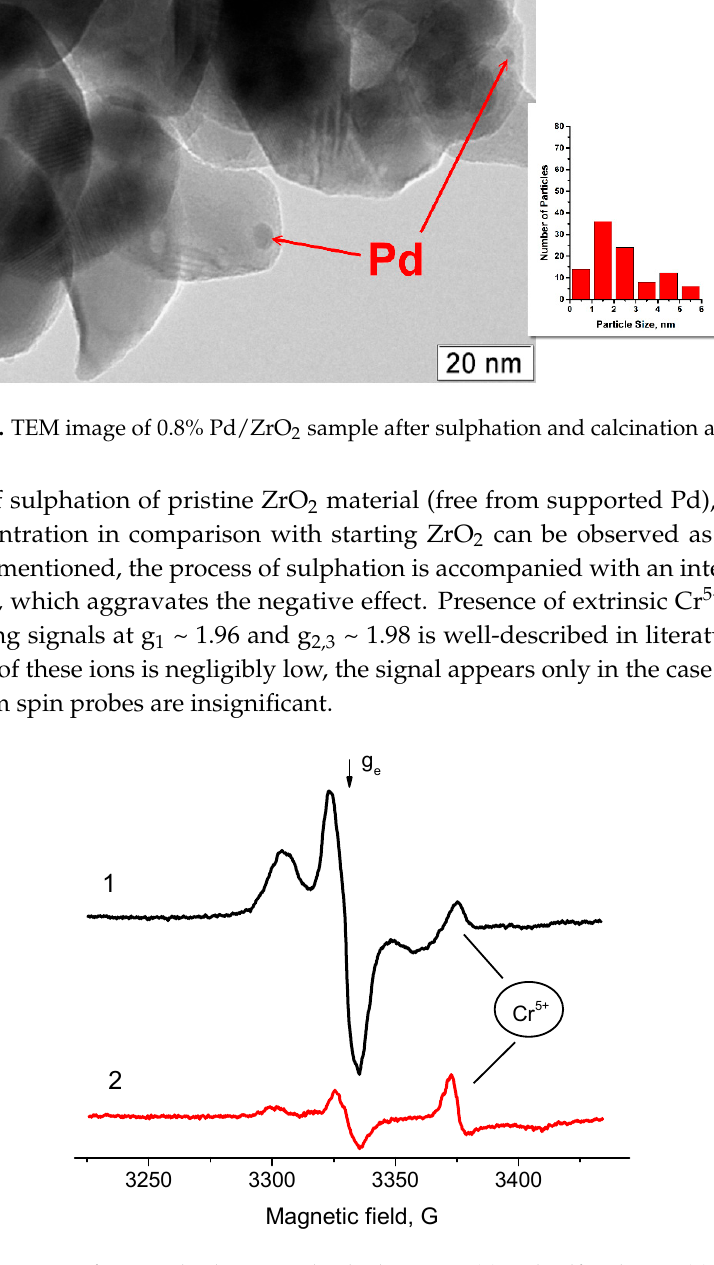
◦ 2 ( 1 ) and sulfated ZrO 2 ( 2 ). T act = 500